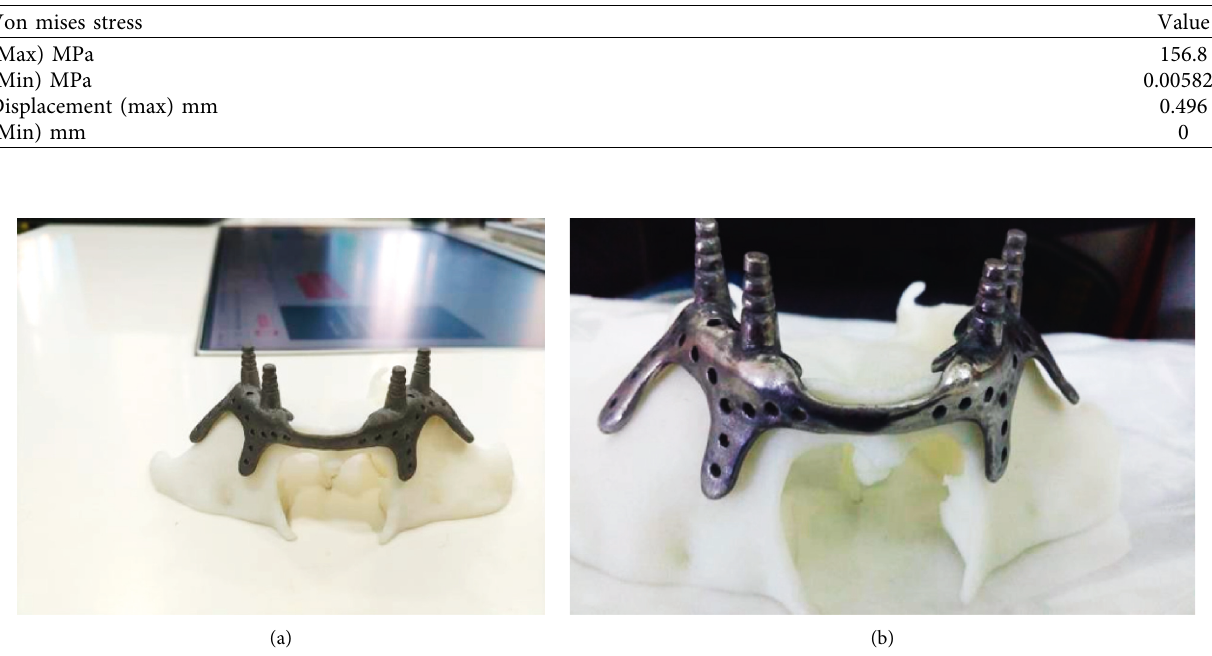
Figure 5: (a) Checking the adaptability of the implant, (b) implant after machining and